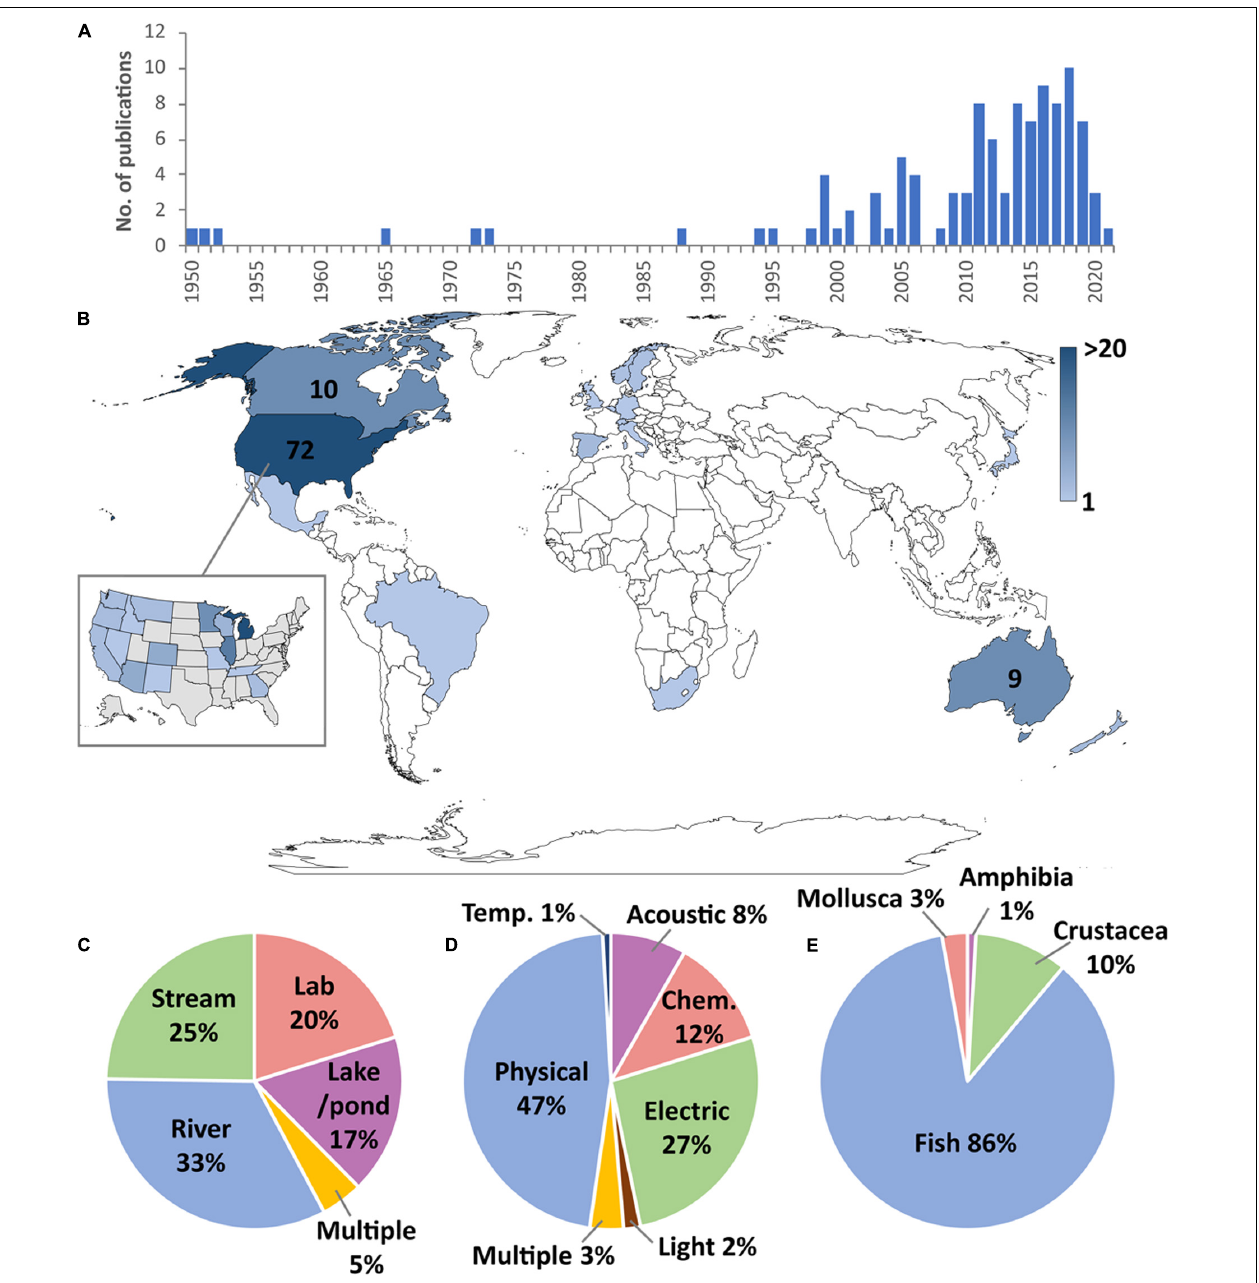
FIGURE 1 | (A) Number of publications involving the use of exclusion barriers by year. (B) Number of publications per country (countries with more than five studies have publication numbers shown and inset shows distribution within the United States). (C) Proportion of studies focussing on different habitat types. (D) Percentage of studies by barrier type. (E) Percentage of studies by AIS